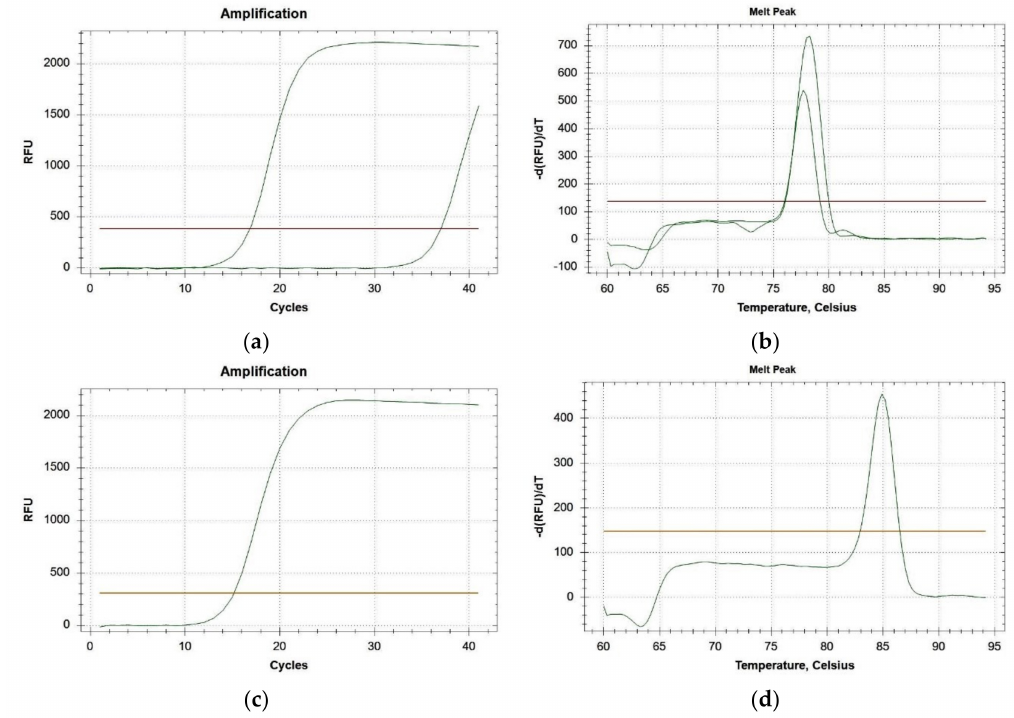
Figure 1. ( a ) Examples of amplification curves of Verrallia aucta ITS2 region detected when DNA extracted from two parasitized samples was used as template in real-time PCR; ( b ) melting curves of the ITS2 amplicons obtained from the same samples; ( c ) example of amplification curve of Philaenus spumarius / Neophilaenus campestris 18SrRNA gene amplified in real-time PCR; and ( d ) the melting curve of the 18SrRNA